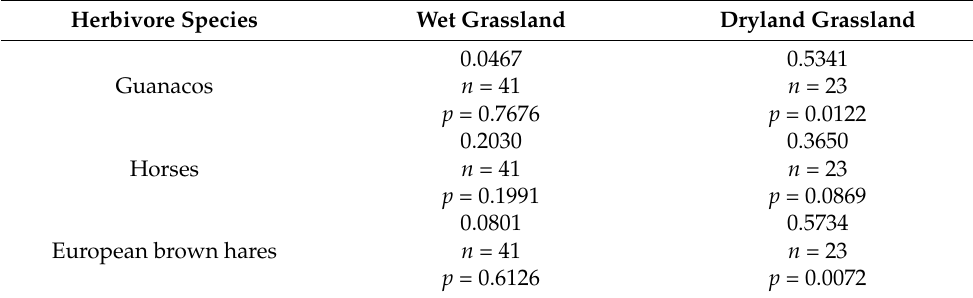
Table 3. Spearman’s rank correlation coefficients between the botanical composition of the guanacos, horses, and European brown hares’ diet and the botanical composition of grasslands. For each case, the number of pairs of observations ( n ) and the statistical significance of the correlation ( p -value) are included.